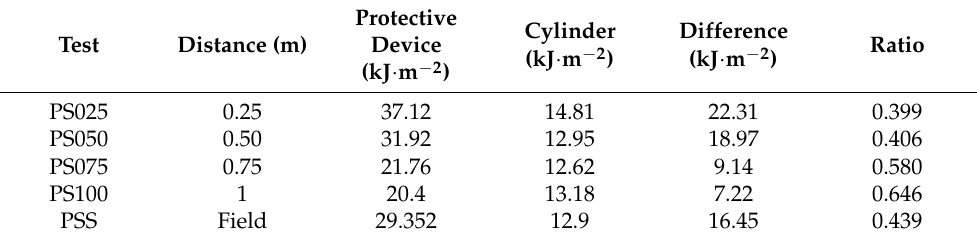
Table 2. Integral of heat flux on surfaces of the cylinder and